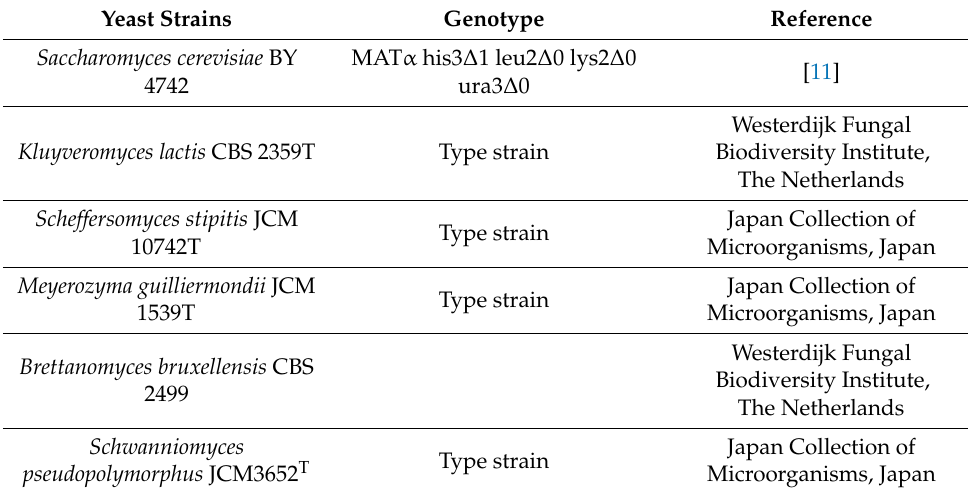
Table 2. List of yeast strains transformed in this study and of plasmids and oligonucleotides used as